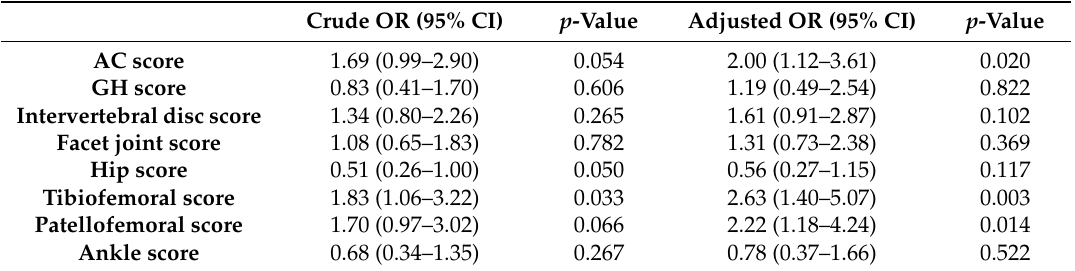
Table 2. Results of ordinal logistic regression analysis with each joint as outcome